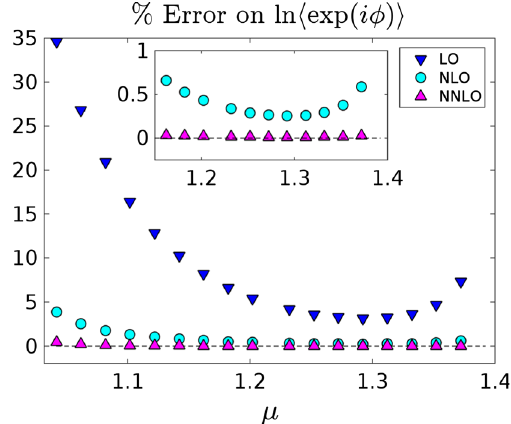
Fig. 10 Relative difference between the moment approximation and the full answer. As expected, the approximation works better in the strong sign-problem